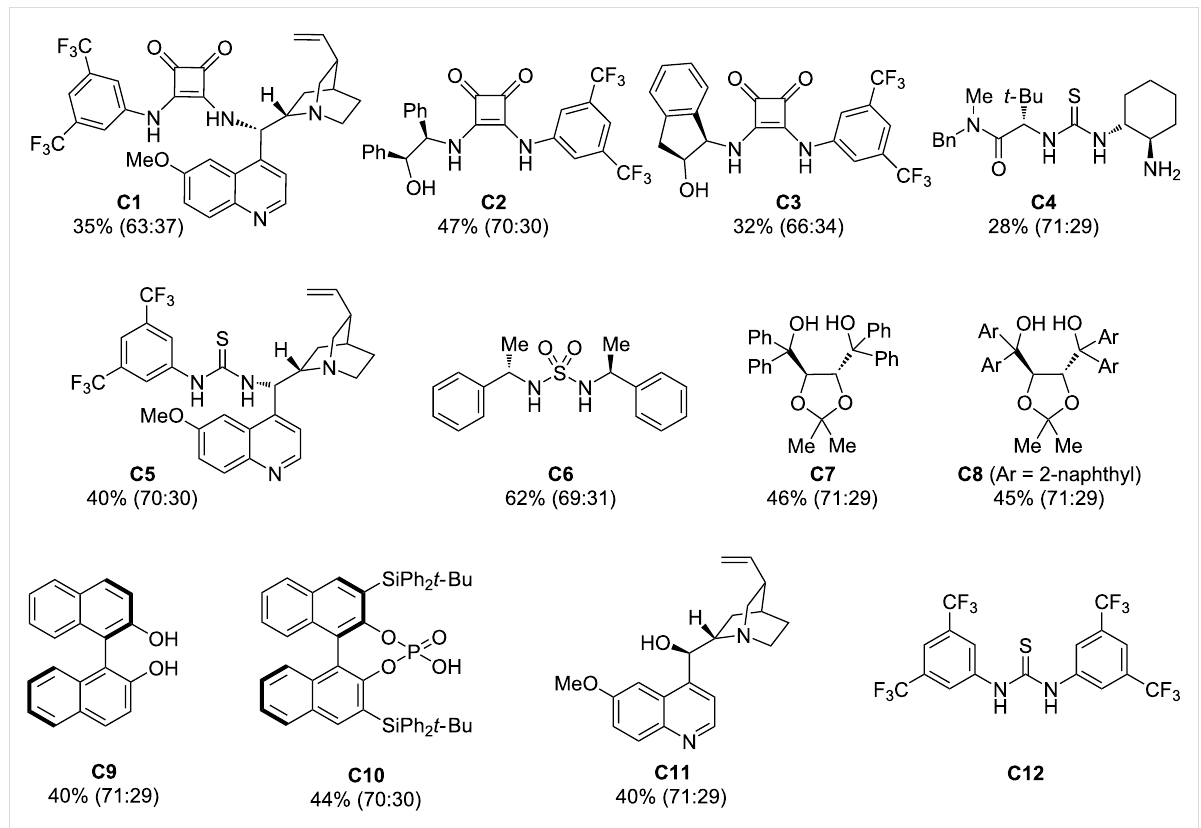
Figure 1: Organocatalysts used in this study. Conditions: typical procedure: 1. Et 3 N (4.9 equiv), DCM, − 60 °C, 5 min; 2. Me 3 SiOTf (1.6 equiv), cata- lyst (10 mol %), − 60 °C; 3. rt, 24 h.